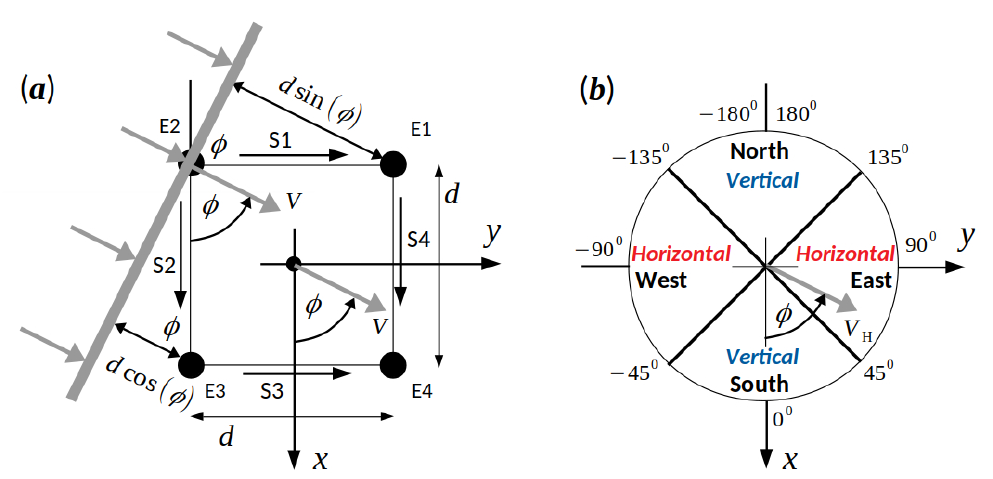
Figure 4. ( a ) Schematic description of the method used to estimate conduction velocity amplitudes and directions of EHG waves (adopted from [36]). ( b ) Distribution of sectors (South, East, North, and West) and propagation directions (Vertical and Horizontal) on the abdominal wall according to the selected coordinate